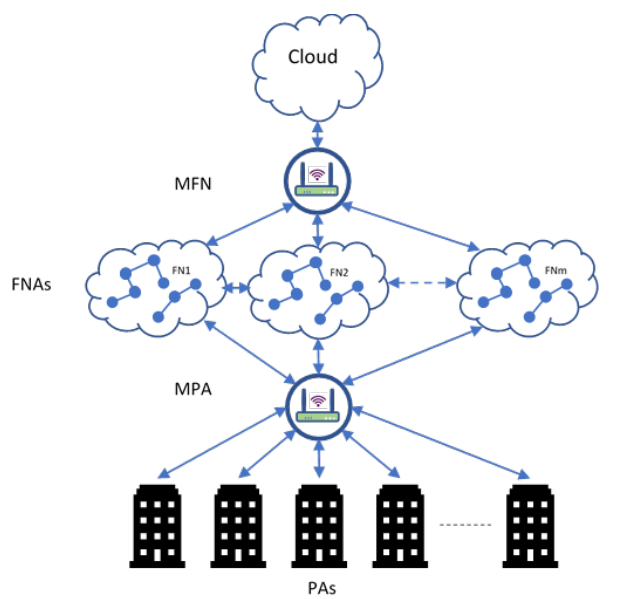
Figure 3. CHTM model